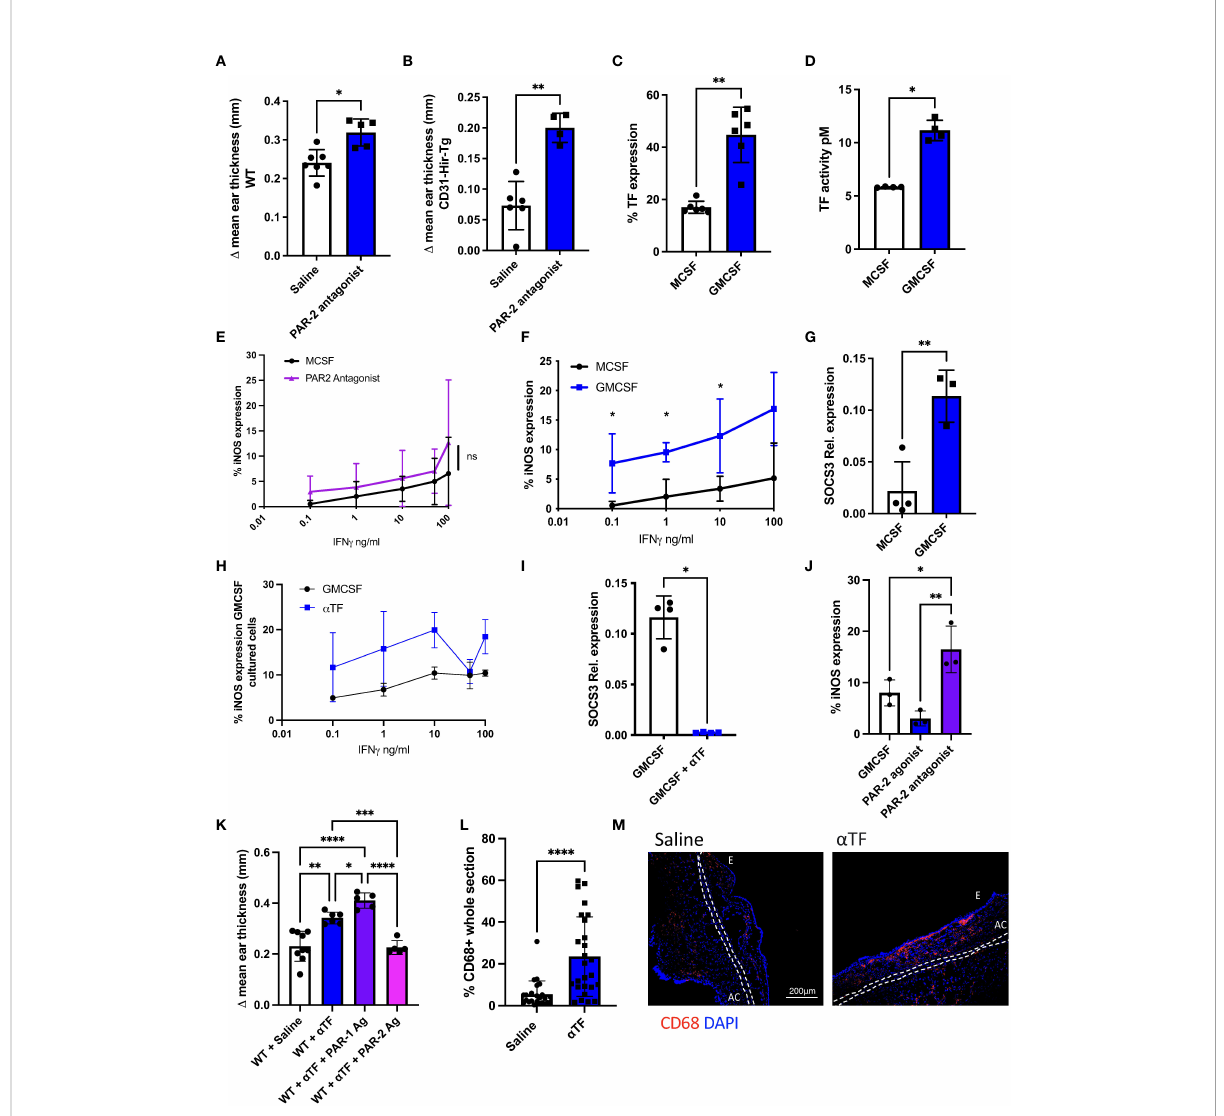
FIGURE 3 Basal PAR-2 signalling, regulated by macrophage TF expression, sets threshold for macrophage sensitivity to IFN g responsiveness. (A, B). The impact of inhibiting PAR-2 signalling on the outcome of DTH in C57BL/6 (WT-A) or CD31-Hir-Tg mice a . Prior to oxazolone re-challenge, mice received IP saline (n= 7 in A; n=6 in B) or 10microM/g PAR-2 antagonist (n= 5 in A; n=4 in B). Data presented as D mean ear thickness 24 hours after rechallenge. (C). TF expression by day 5 MCSF- or GMCSF-derived BMM, determined by fl ow cytometry. Data from 6 experiments. (D). TF activity of cell lysates from day 5 MCSF (n=4) or GMCSF (n=4)-derived BMM, as measured by production of FXa, when FX provided with FVIIa. (E). Day 5 MCSF-derived BMM incubated for 3 hours with MCSF (black circle n=3) or PAR-2 antagonist (purple triangle n=3) before a 24-hour incubation with increasing doses of IFN g . Data expressed as % of cells expressing iNOS analysed by fl ow cytometry in presence of PAR-2 antagonist compared to control. (F). Day 5 GMCSF-or MCSF-derived BMM incubated for 24 hours with increasing amounts of IFN g . Data expressed as % of cells expressing iNOS analysed by fl ow cytometry. Data from 3 experiments. (G). Relative SOCS3 expression, assessed by quantitative RT-PCR, by day 5 MCSF (n=4) vs. GMCSF-derived BMM (n=3). (H). Day 5 GMCSF-derived BMM incubated for 3 hours with GMCSF or 10mg/ml anti-TF mAb before 24-hour incubation with increasing doses of IFN g . Data expressed as % of cells expressing iNOS analysed by fl ow cytometry. Data from at least 3 experiments. (I). Day 5 GMCSF-derived BMM incubated with GMCSF (n=4) or 10mg/ml anti-TF-mAb (n=4) for 3 hours before quantitative RT-PCR of SOCS3 expression (relative to TBP). (J). Day 5 GMCSF-derived BMM incubated for 3 hours with GMCSF or 100mM PAR-2 agonist or antagonist before a 24-hour incubation with IFN g (1ng/ml). Data expressed as % of cells expressing iNOS analysed by fl ow cytometry. Data from 3 separate experiments. (K). WT mice were treated with IP saline (n=9) or 10µg/g IP anti-TF Ab (n=6) on day 4 after sensitisation with oxazolone +/- 10µM/g IP PAR-1 agonist (n=5) or PAR-2 agonist (n=5) 24 hours prior to re-challenge with oxazolone. (L) Data presented as D mean ear thickness. (L, M) : IF analysis of CD68 + in fi ltration into the oxazolone-painted ears of mice receiving saline or anti-TF-mAb. M : Quanti fi cation of CD68 + expression. N : Representative two colour IF sections through oxazolone-painted ears. Images show staining with CD68 (red) and DAPI (blue). Dotted lines demarcate the auricular cartilage (AC). E= epidermis. Samples were compared using a Mann Whitney U test with two tailed p-values (Fig 3A-D,G,I+L), and Kruskal – Wallis one-way anova for multiple comparisons (Fig3J+K). Bar data represents mean +SD. *P < 0.05 **P < 0.01 ***P < 0.001 ****P < 0.0001. ns, non signi fi